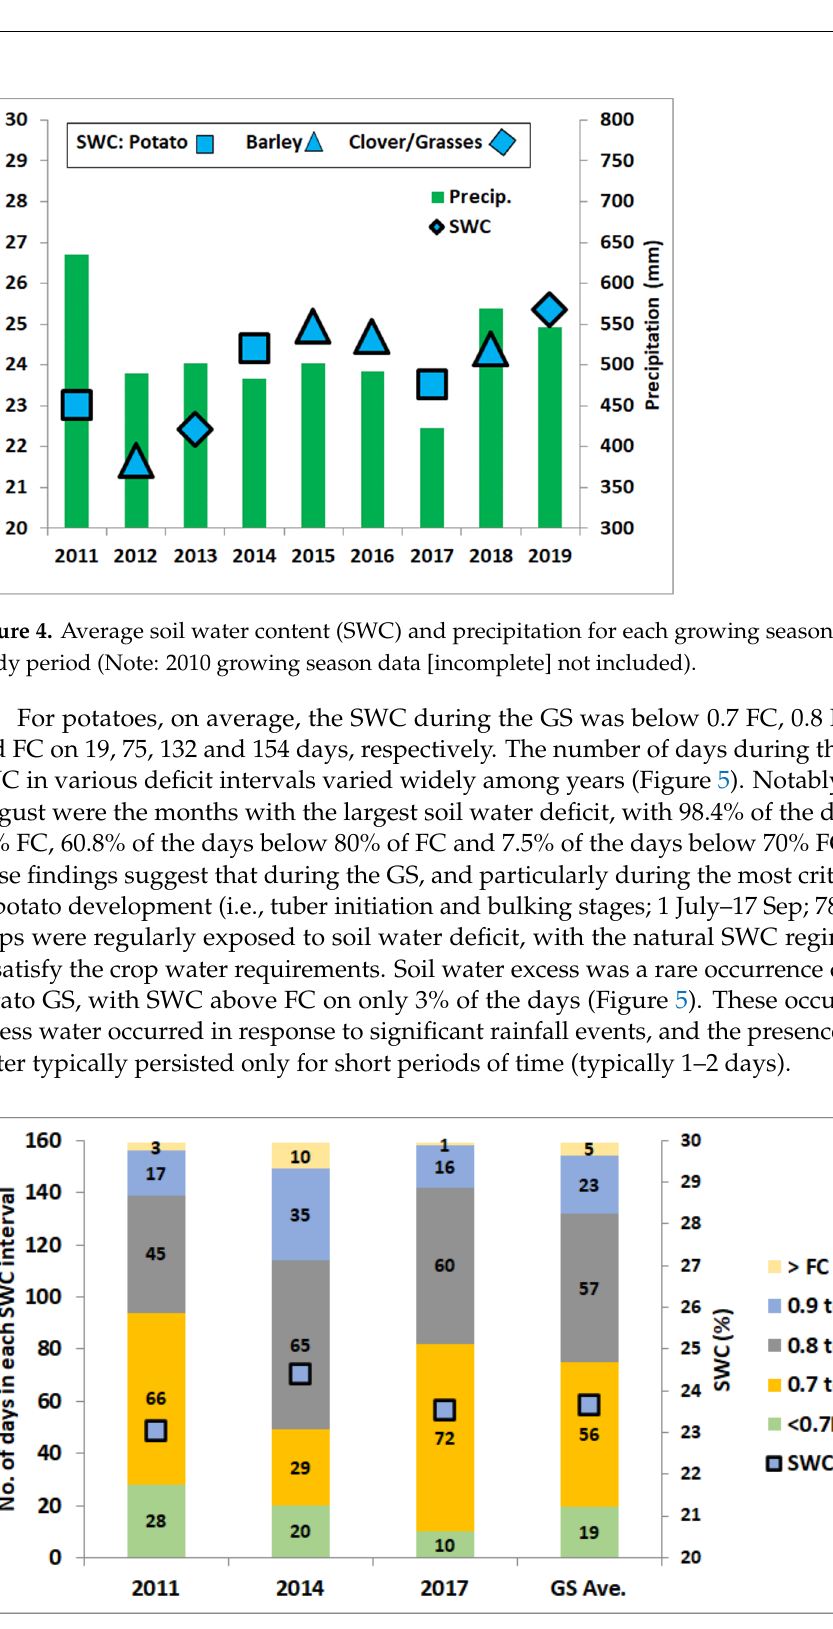
Figure 3. Field capacity (FC) and monthly averages for soil water content (SWC) and precipitation for potato and for all crops for the representative year.